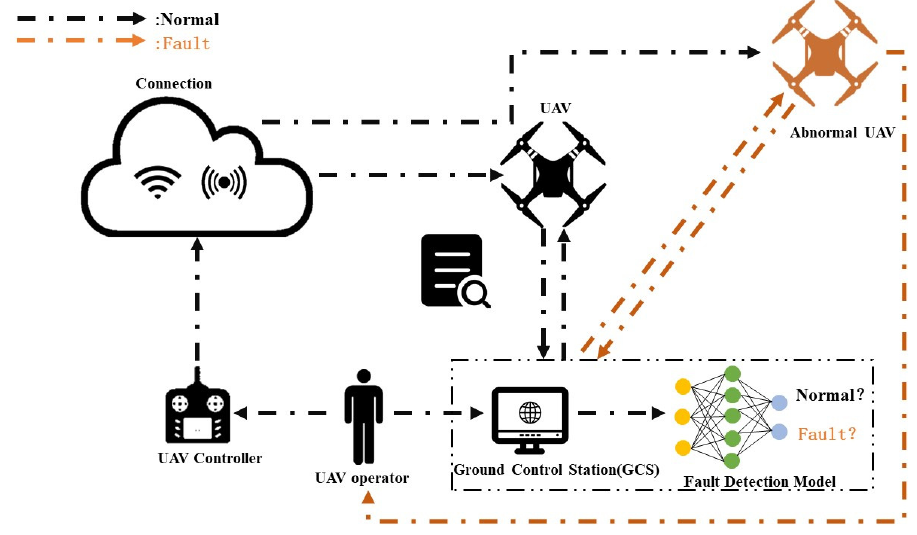
Figure 1. A typical drone anomaly detection network architecture.